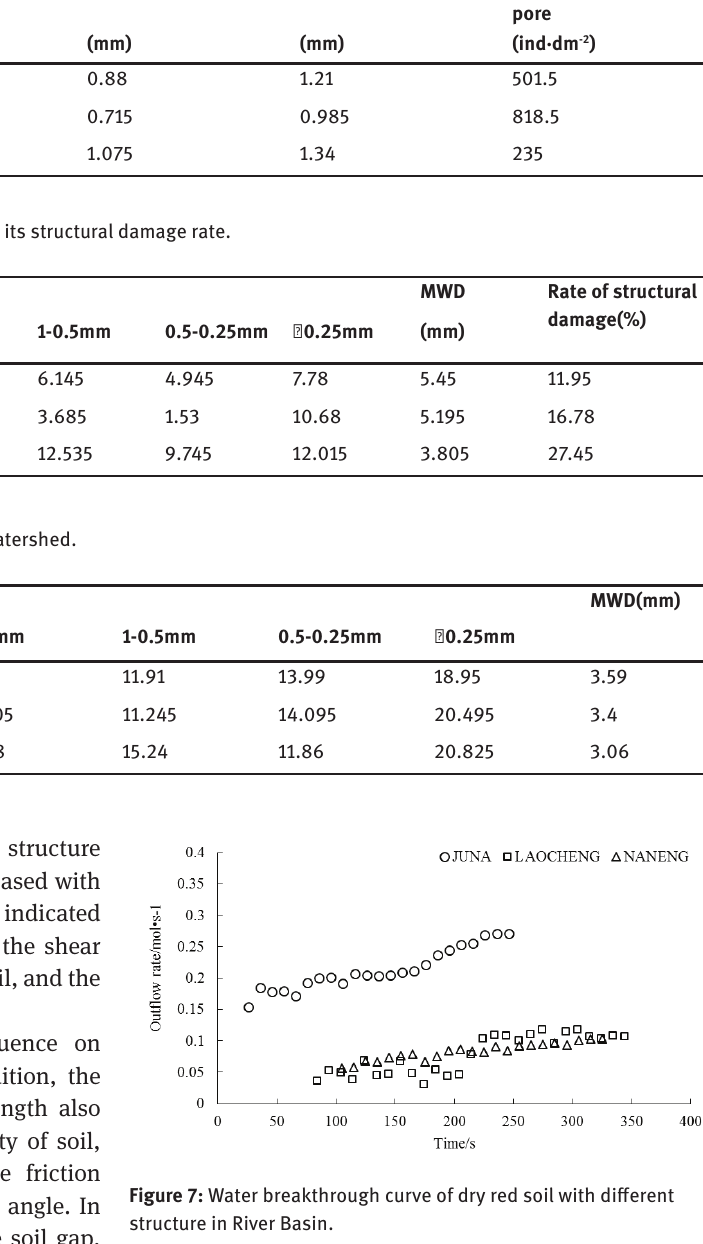
Table 3: Range and quantity of large pore radius in watershed. Watershed Thickness of test soil